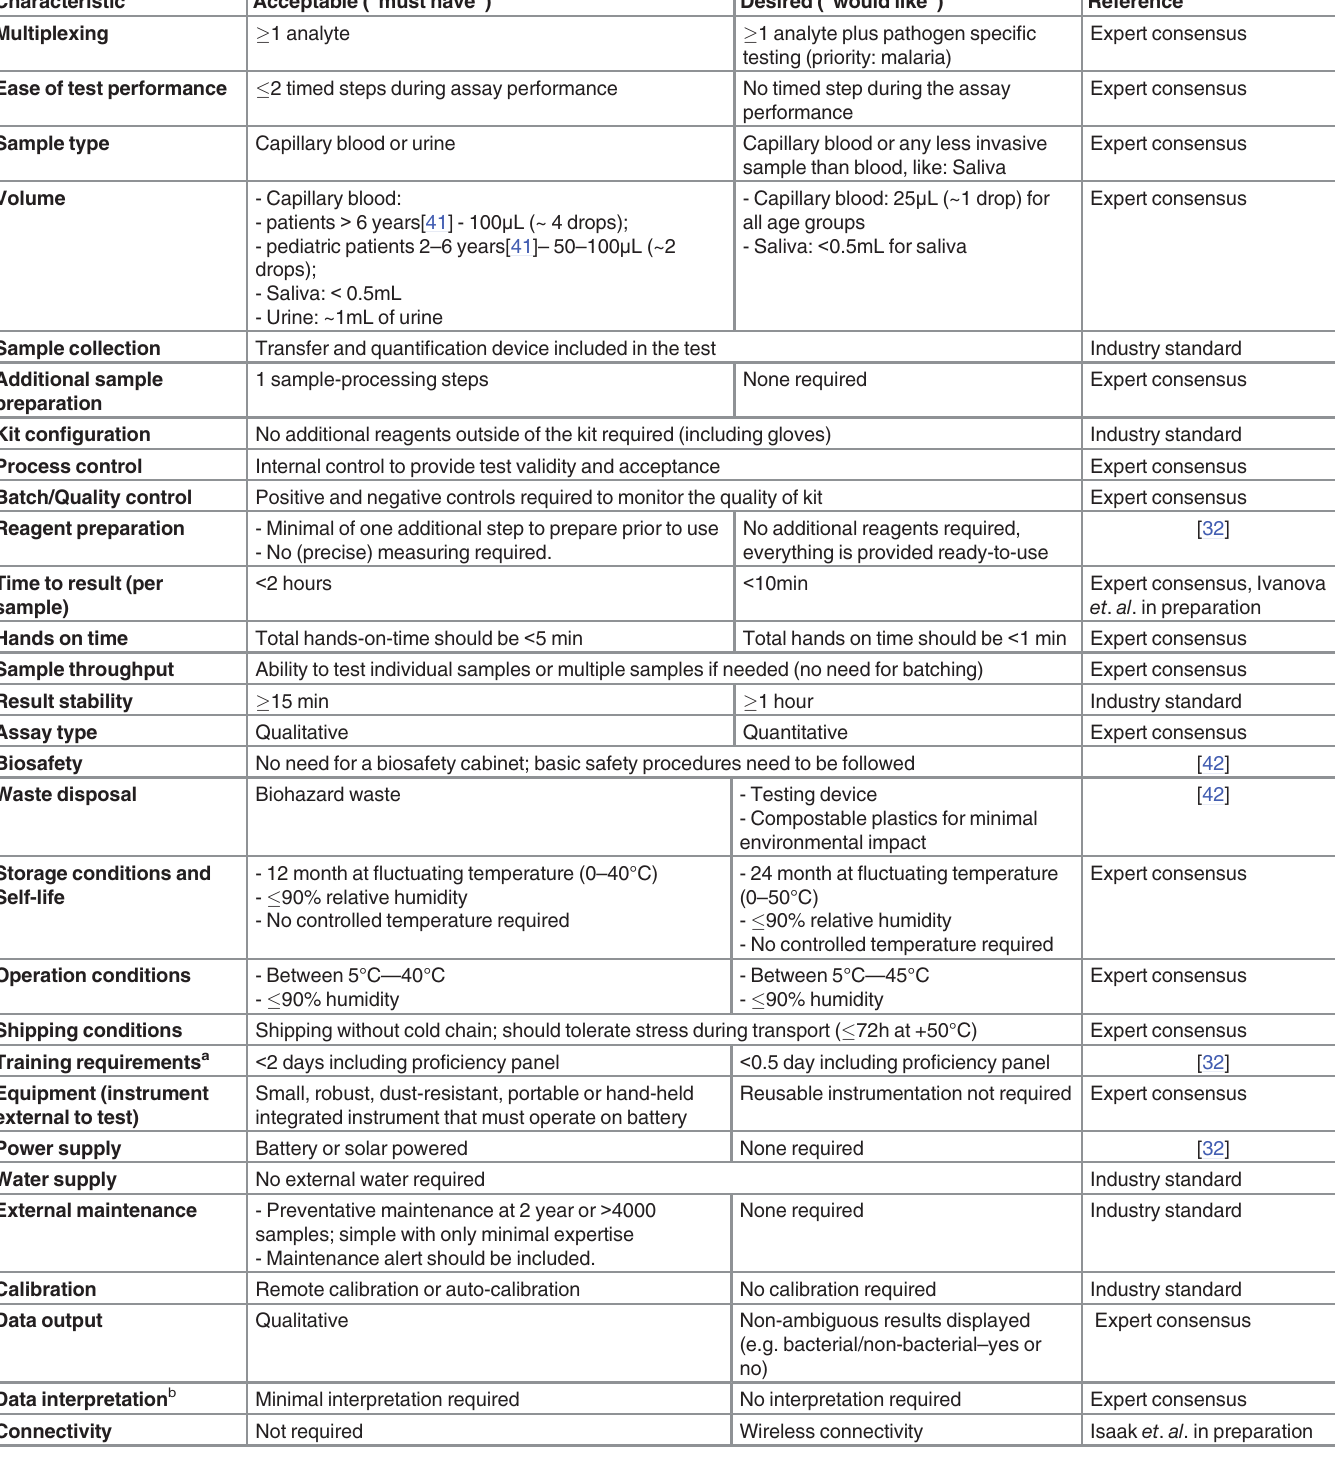
Table 3. Acceptable and desired target product profile characteristics focused on operational characteristics, as defined by an expert consensus process 2015 – 16.